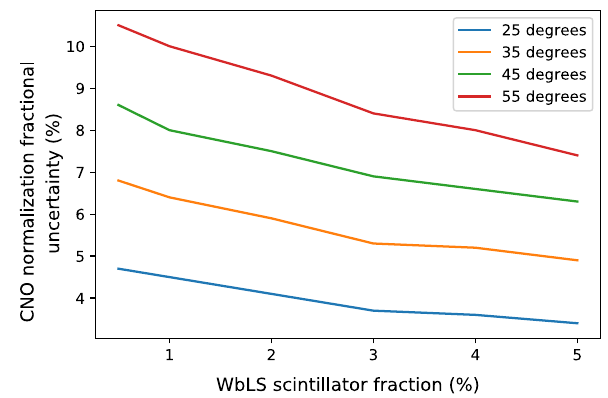
Fig. 9 Fractional uncertainty on the CNO normalization parameter as a function of angular resolution and WbLS scintillator fraction, for Theia